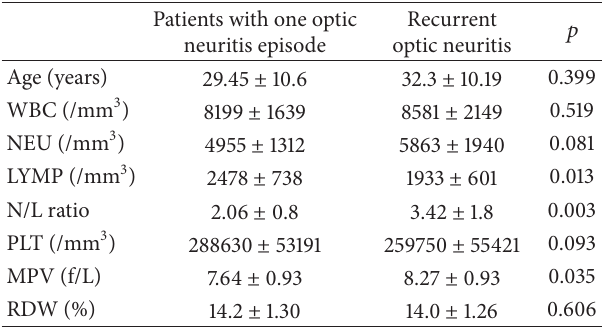
Table 2: Demographic characteristics and laboratory results of one episode optic neuritis patients and recurrent optic neuritis